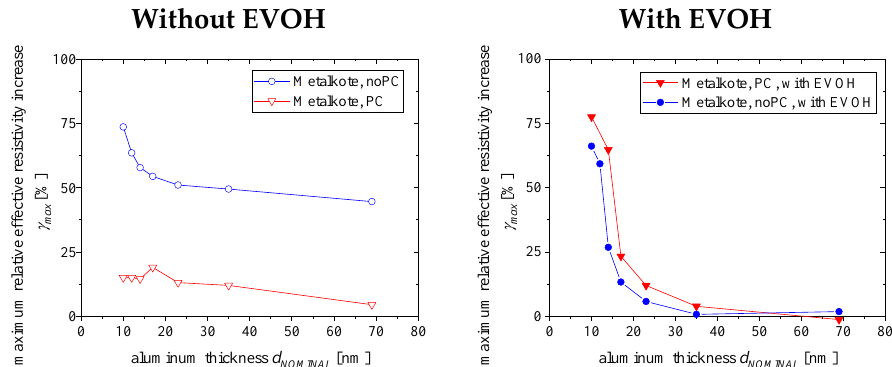
Figure 6. Increasing roughness R Z and porosity of the substrate paper Metalkote increased the effective resistivity ρ EFF due to defects in the aluminum coating. Although the EVOH coating only had a minor impact on roughness values R Z , the resistivity was lower due to the lower porosity. PC/noPC = paper surface with/without pigment coating. EVOH = ethylene vinyl alcohol lacquer.